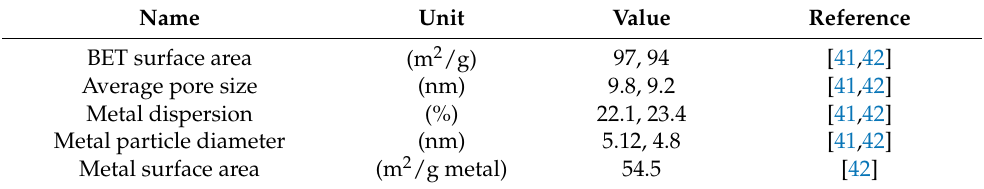
Table 6. Properties of 5 wt% Pt–Al 2 O 3 powder catalyst used in the dehydrogenation experiments.